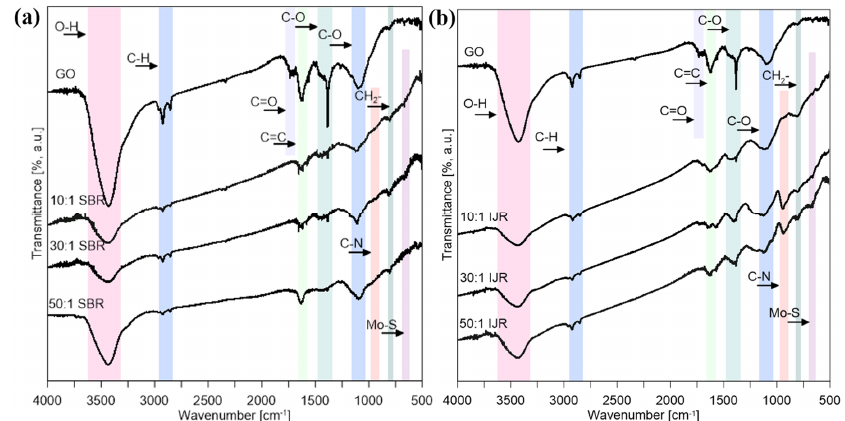
Figure 6. Fourier-transform infrared (FT-IR) spectra of GO and MoS 2 /GO synthesized in ( a ) the semi- Figure6. Fourier-transforminfrared(FT-IR)spectraofGOandMoS 2 / GOsynthesizedin( a )thesemi-batch batch reactor ( b ) the impinging jet reactor. reactor ( b ) the impinging jet